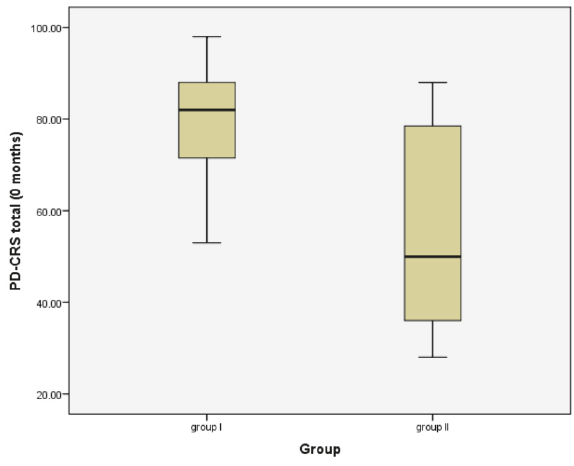
Figure 7: Mean score of PDCRS for ApoE 𝜀 4 carriers between Group I and Group II.